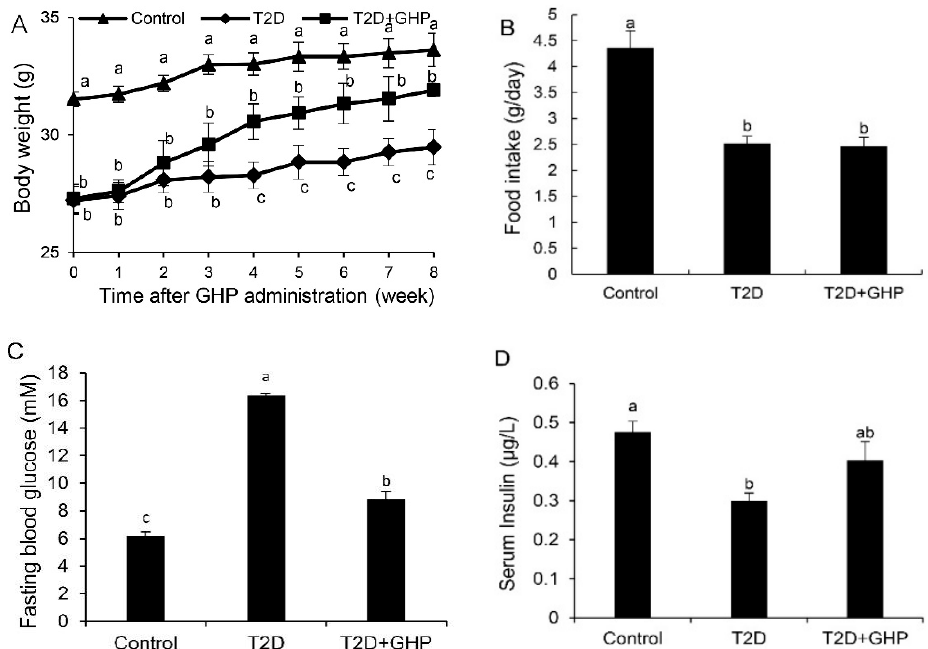
Figure 1. Glycomacropeptide hydrolysate (GHP) supplementation ameliorated body weight, fasting blood glucose (FBG) and serum insulin levels of type 2 diabetes (T2D) mice. ( A ) Body weight during GHP administration. ( B ) Food intake during GHP administration. Control group was fed with normal diet; T2D and T2D + GHP groups were fed with high-fat diet. FBG levels ( C ) and fasting serum insulin levels ( D ) after two-month GHP administration. Results were expressed as means ± the standard error of the mean (SEM) ( n = 8). Different letters (a–c) indicate significant difference ( p < 0.05).